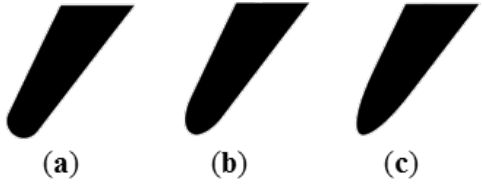
Figure 9. Front-end curvature distributions of blades with different leading